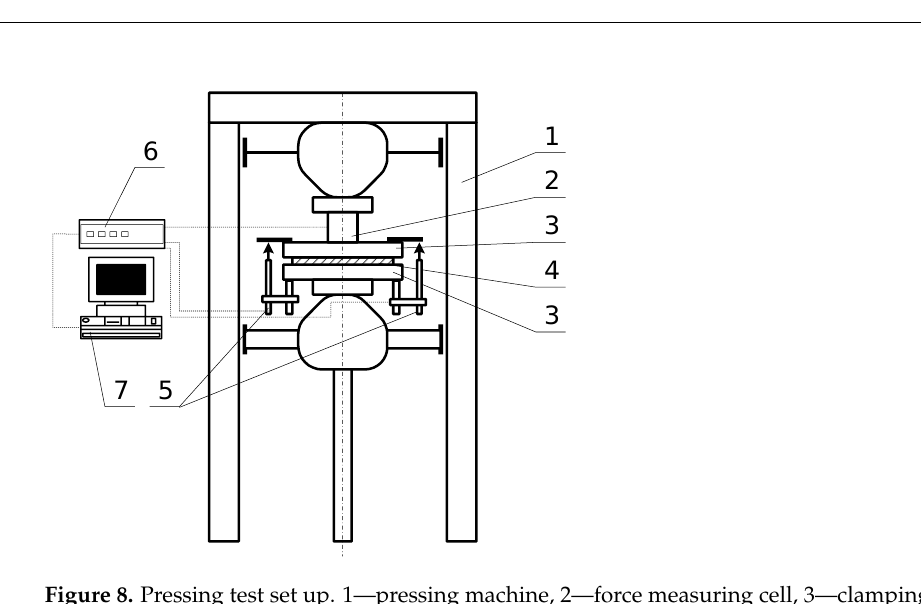
10 of 18 Figure 7. Chamber of manufacturing the sample piece.